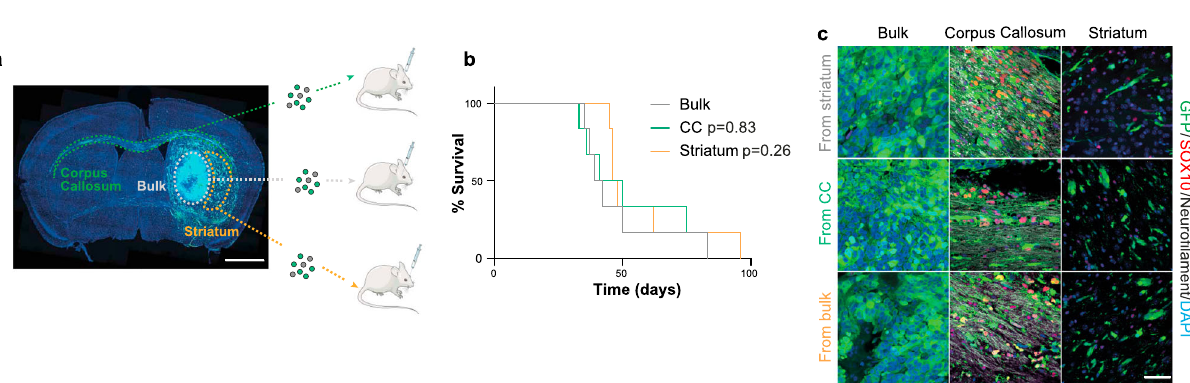
Fig. 4 Differentiation depends on continuous exposure to white matter. a schematic representation of experimental work fl ow. b Kaplan Meier survival plot of nude mice injected with G144 cells acutely isolated from the bulk, corpus callosum (CC) and striatum of primary xenografts. n = 6 mice/group. c Representative images of secondary GFP + tumours stained for neuro fi lament (grey) to identify axonal bundles, SOX10 (red) and DAPI (blue). Tumour areas from the indicated brain regions are shown revealing a differentiation pattern identical to primary lesions. Scale = 50 µ